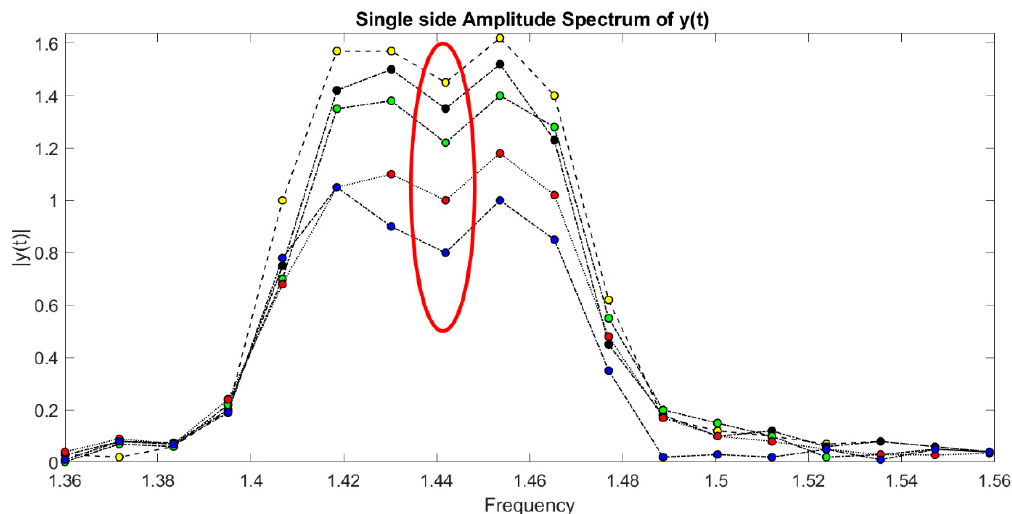
Figure 12. Detected leaks from 7 to 11: magnitude vs. frequency.